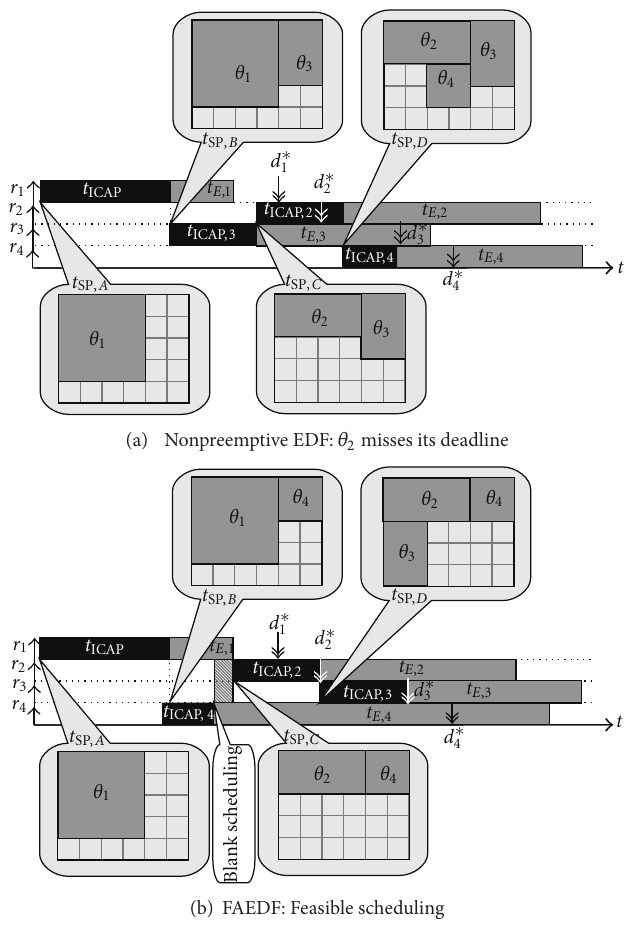
Figure 4: EDF and FAEDF